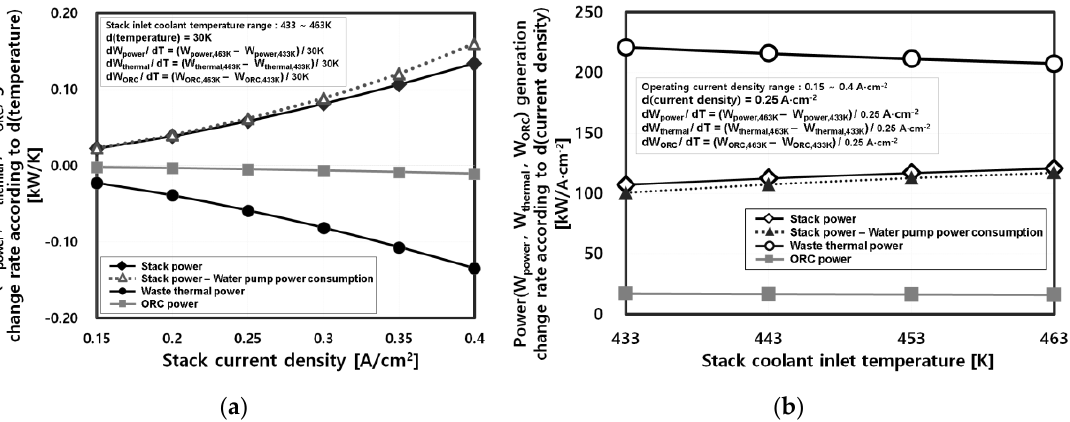
Figure 10. ( a ) The rate of change of stack power, waste heat generation, and ORC power generation according to operating temperature for each stack current density; ( b ) The rate of change in stack power, heat generation, and ORC power generation performance according to the current density for each stack coolant inlet temperature.